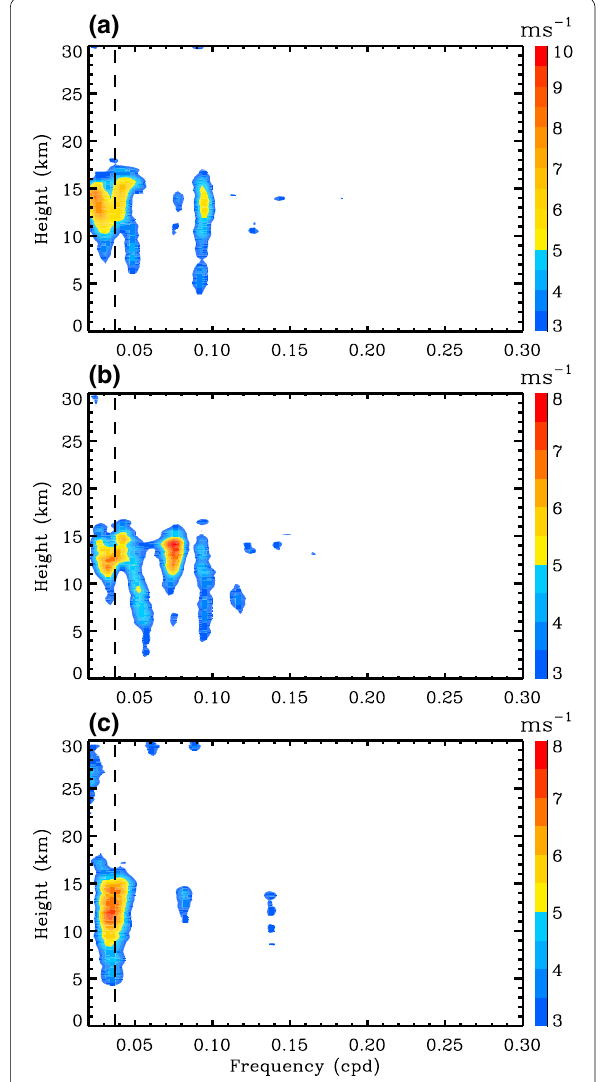
Fig. 5 Lomb–Scargle spectrum of zonal wind from radiosonde observations in a Hilo, b Kauai and c Pago Pago. The dashed vertical line corresponds to a period of 27 days